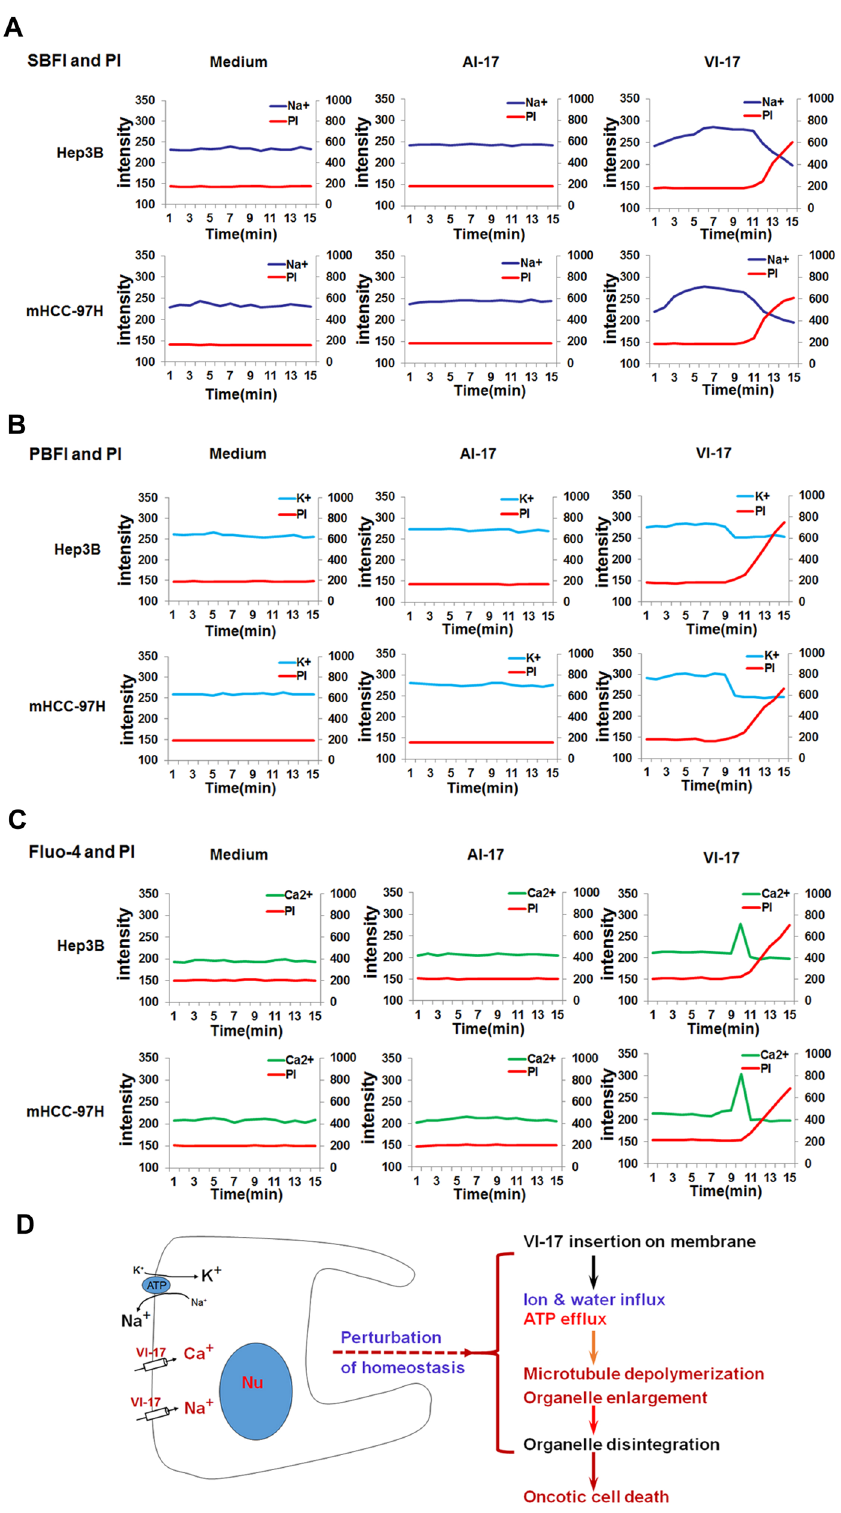
Figure 8. VI-17 rapidly induced selective leakage of sodium ion. (A) Analysis of the intensity of cellular Na + signal using time phase microscopy. (B) Analysis of the intensity of cellular K + signal using time phase microscopy. (C) Analysis of the intensity of cellular Ca 2+ signal using time phase microscopy. (D) Cartoon for the dynamics of VI-17 elicited